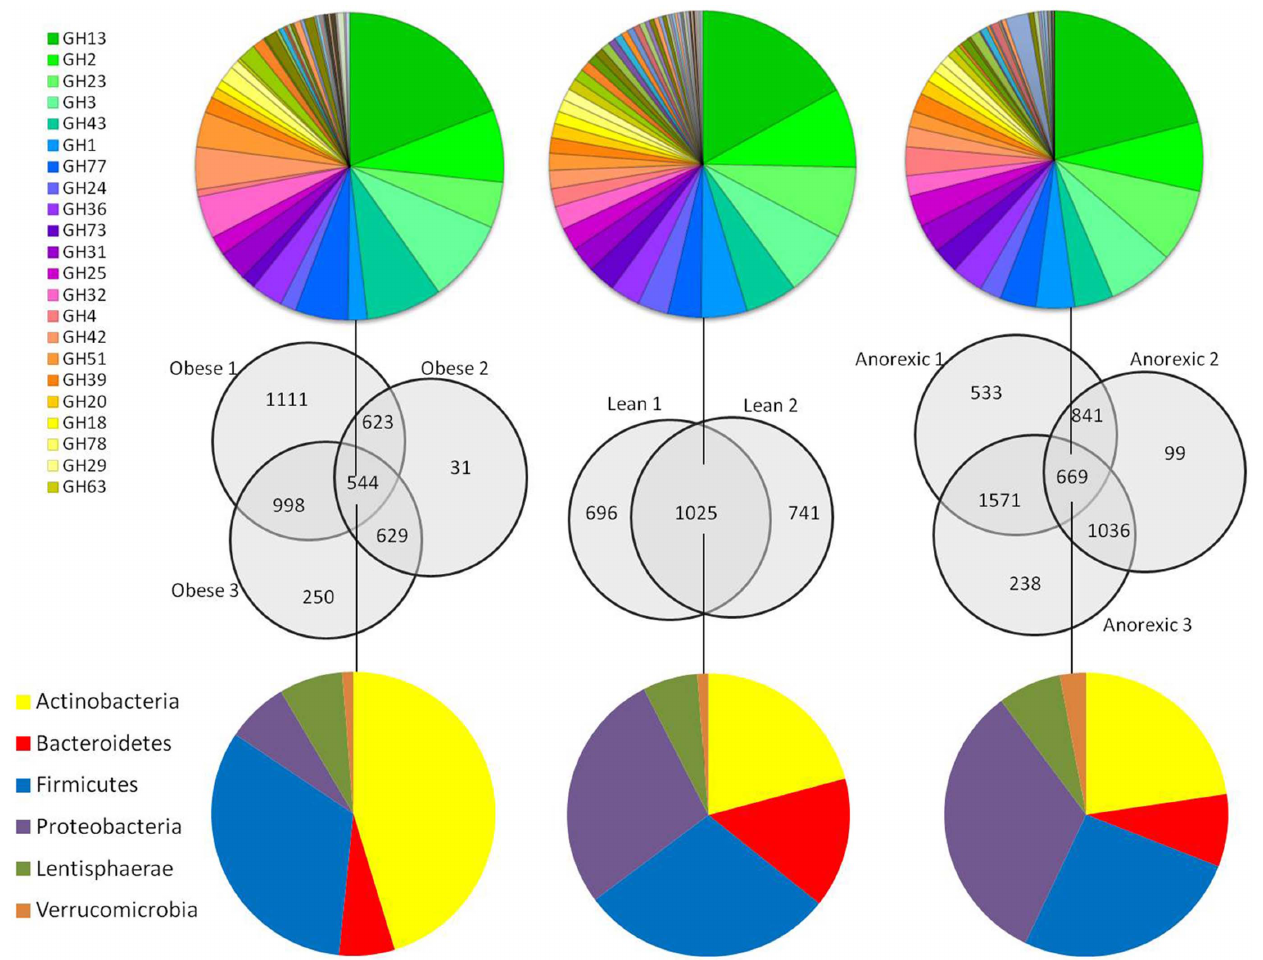
Figure 2. Comparison of detected CAZyme genes between and within samples. The numbers of unique and shared CAZyme genes between samples are represented as a Venn diagram. The phylum distribution of the core CAZyme genes of each group are shown in different colors (blue, Firmicutes; red, Bacteroidetes; yellow, Actinobacteria; purple, Proteobacteria; olive green, Lentisphaerae; brown, Verrucomicrobia). The CAZyme family composition of the cores is shown in rainbow colors.